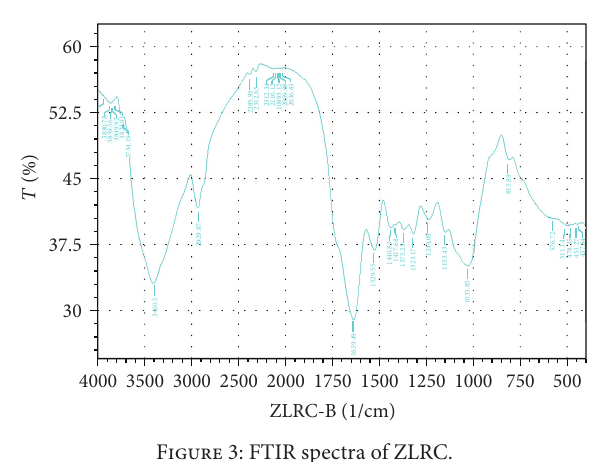
F 3: FTIR spectra of